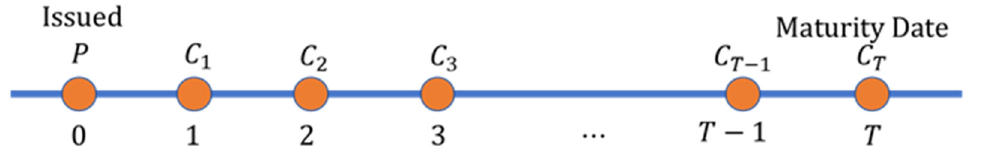
Figure 3. The diagram of coupon cash flow until time maturity T